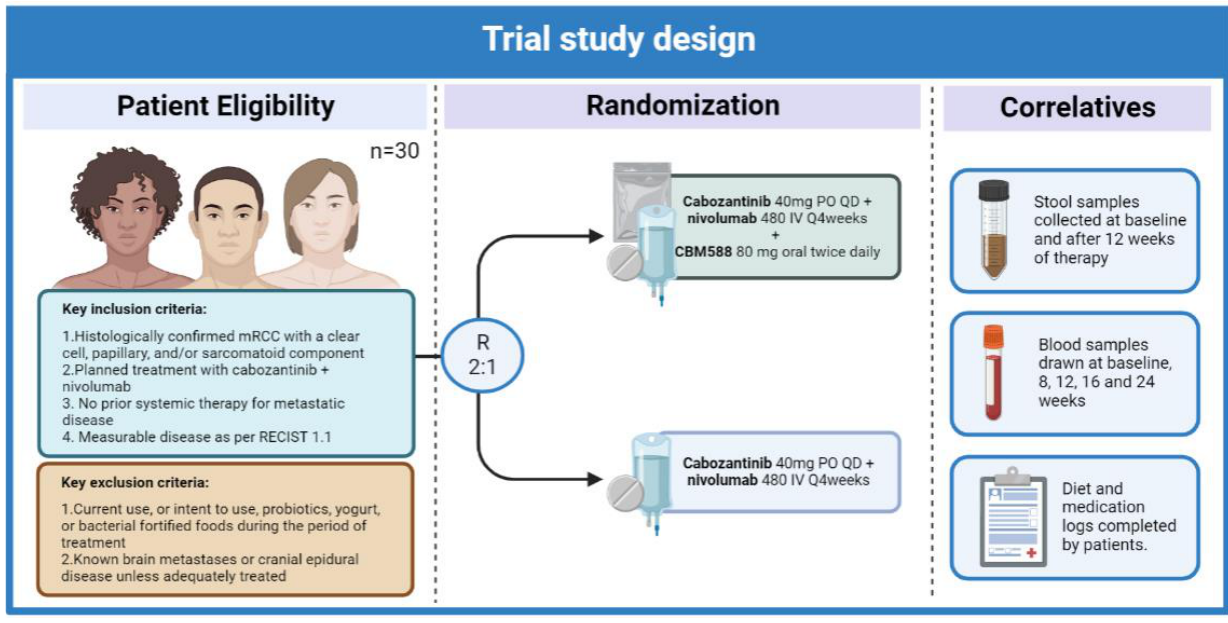
Figure 1. Study design for the phase I cabozantinib plus nivolumab +/ − CBM588 trial [97].